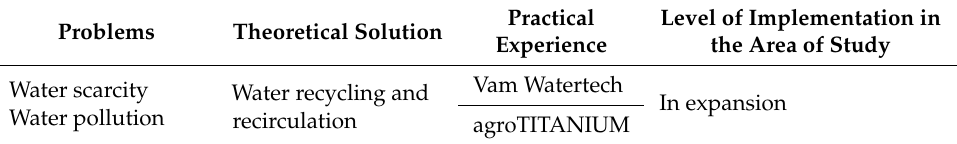
Table 9. Main solutions based on the CE for water